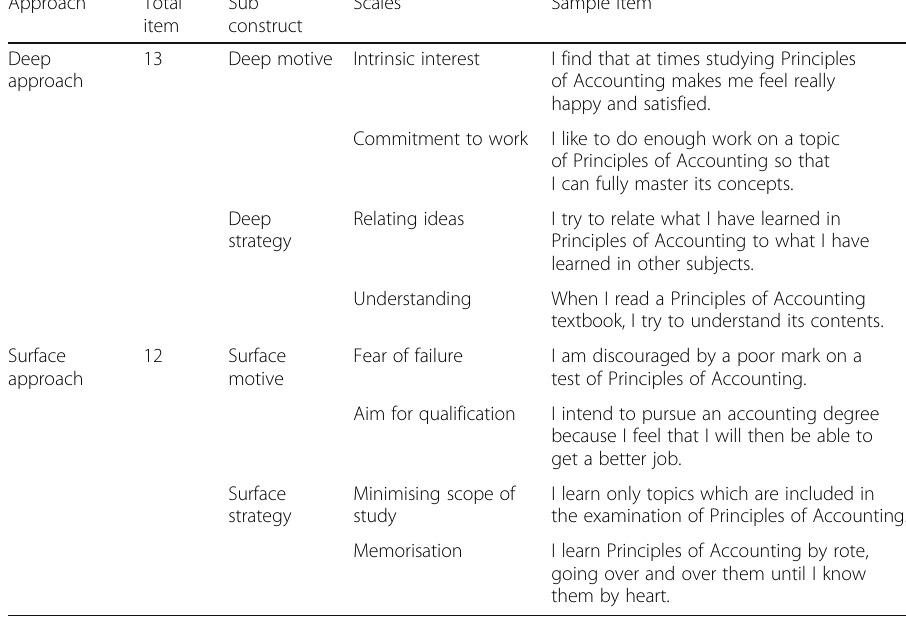
Table 1 Structure and sample items in the adapted R-LPQ-2F instrument Approach Total Sub Scales Sample item construct